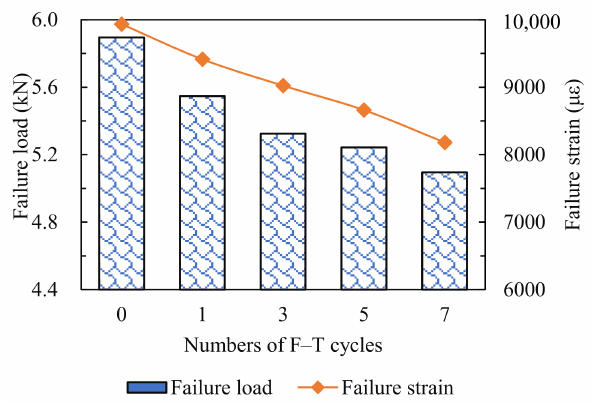
Figure 4. Failure loads and failure strains of